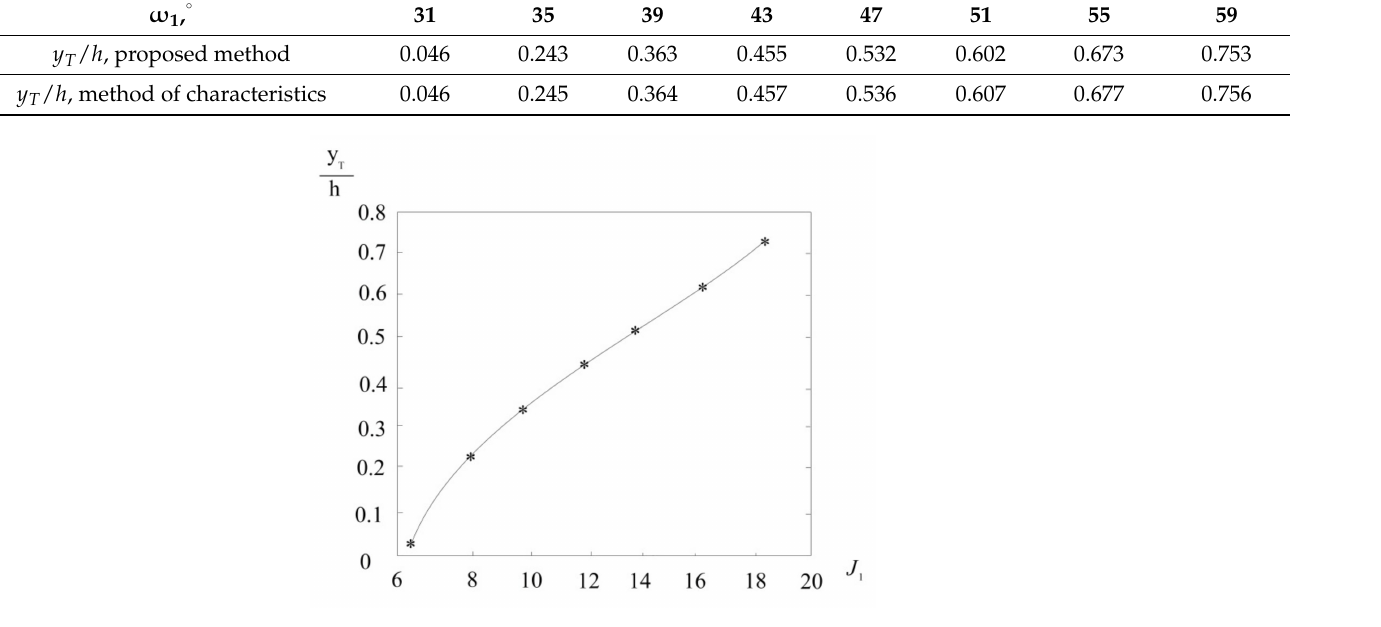
Figure 4. Values of dimensionless Mach stem height ( y T / h ) determined analytically (solid line) and numerically (stars) vs. the strength of the incident shock ( J 1